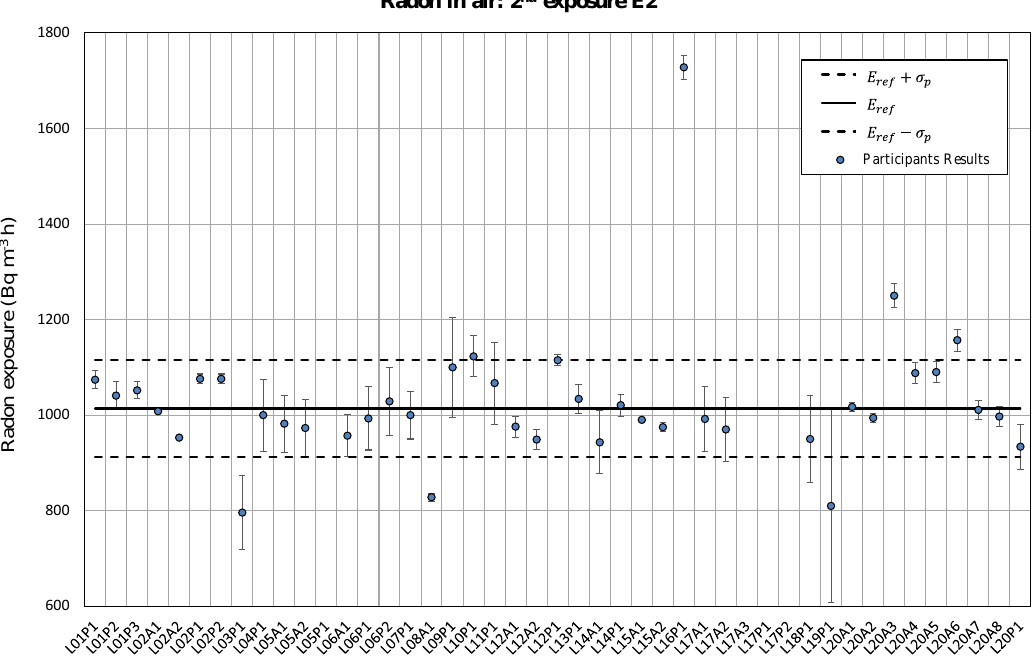
Figure 6. Participant’s results for the second exposure E2 with its associated uncertainty ( k = 1). Exposure reference value is shown with a solid line and the standard deviation σ p = 0.1 E ref with dashed lines.